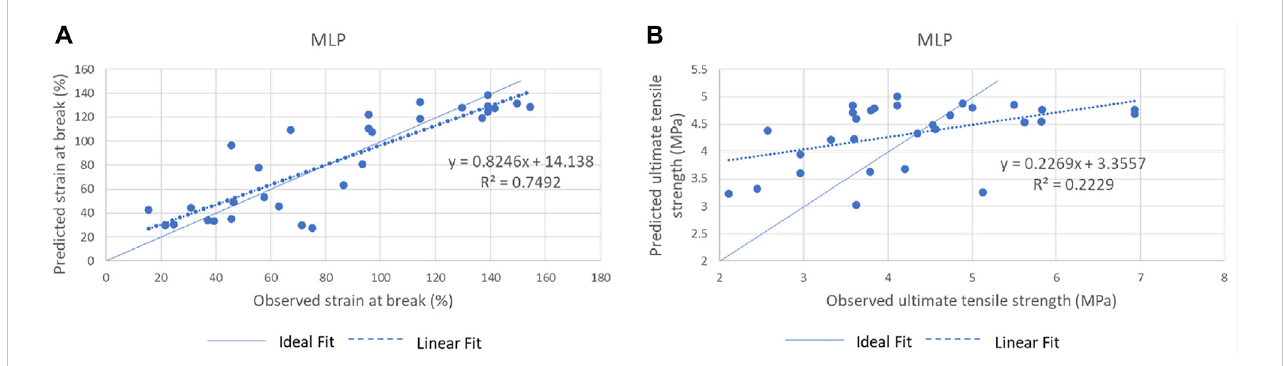
FIGURE 9 Observed values vs. predicted values with multilayer perceptron: (A) strain at break (%) vs. predicted strain at break (%) and (B) observed ultimate tensile strength (MPa) vs. predicted ultimate tensile strength